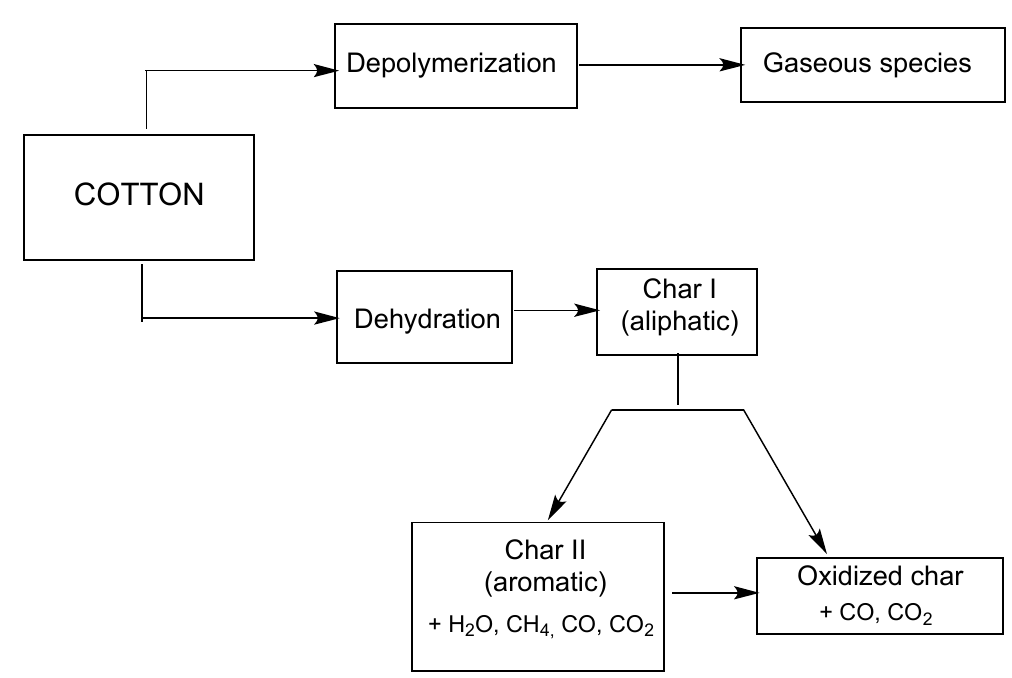
Figure 2. Scheme of cotton degradation.